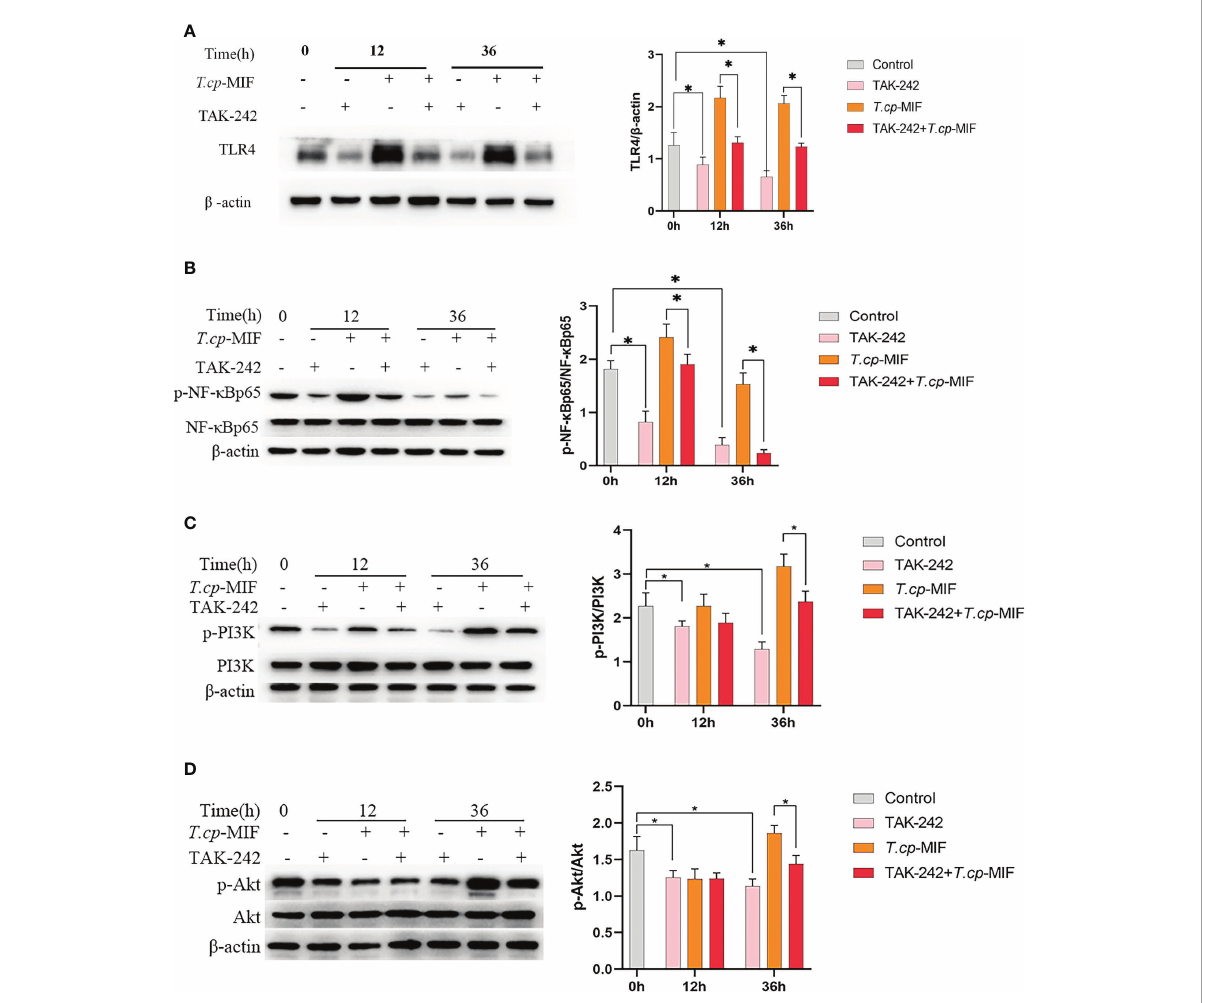
FIGURE 8 The effect of TAK-242 on the expression of macrophage polarization-related proteins. (A – D) The cells were pretreated with TAK-242 (the TLR4 inhibitor) for 6 h, and the expression levels of TLR4, NF- k Bp65, p-NF- k Bp65, PI3K, p-PI3K, Akt and p-Akt were detected by western blot. * indicated P <0.05. Results are showed as the mean of three times of independent experiments ( x ̄ ±SD, n=3).